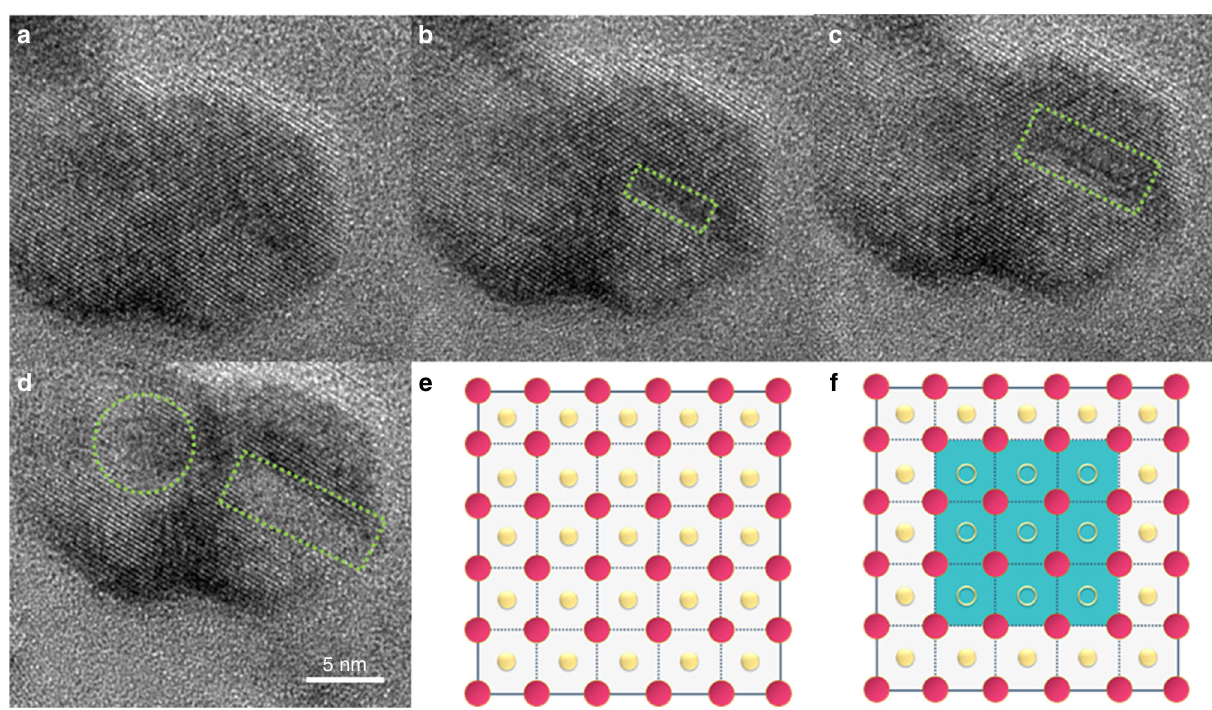
Fig. 2 In situ high-resolution environmental transmission electron microscopy (HRETEM) observations of the In 2 O 3 + x H 2 → In 2 O 3 − x + x H 2 O process. High-resolution images of a stoichiometric In 2 O 3 nanocrystal (S1) at 400 °C a under an N 2 atmosphere and then switched to an H 2 atmosphere for the following times: b 5 min, c 10 min and d 20 min. Scale bars are the same for all images, green squares indicate the formation of an amorphous phase. Graphical representation of the e original and f treated In 2 O 3 , wherein blue region, pink dots, yellow dots and yellow circles represent amorphous phase, In atoms, O atoms and [O],